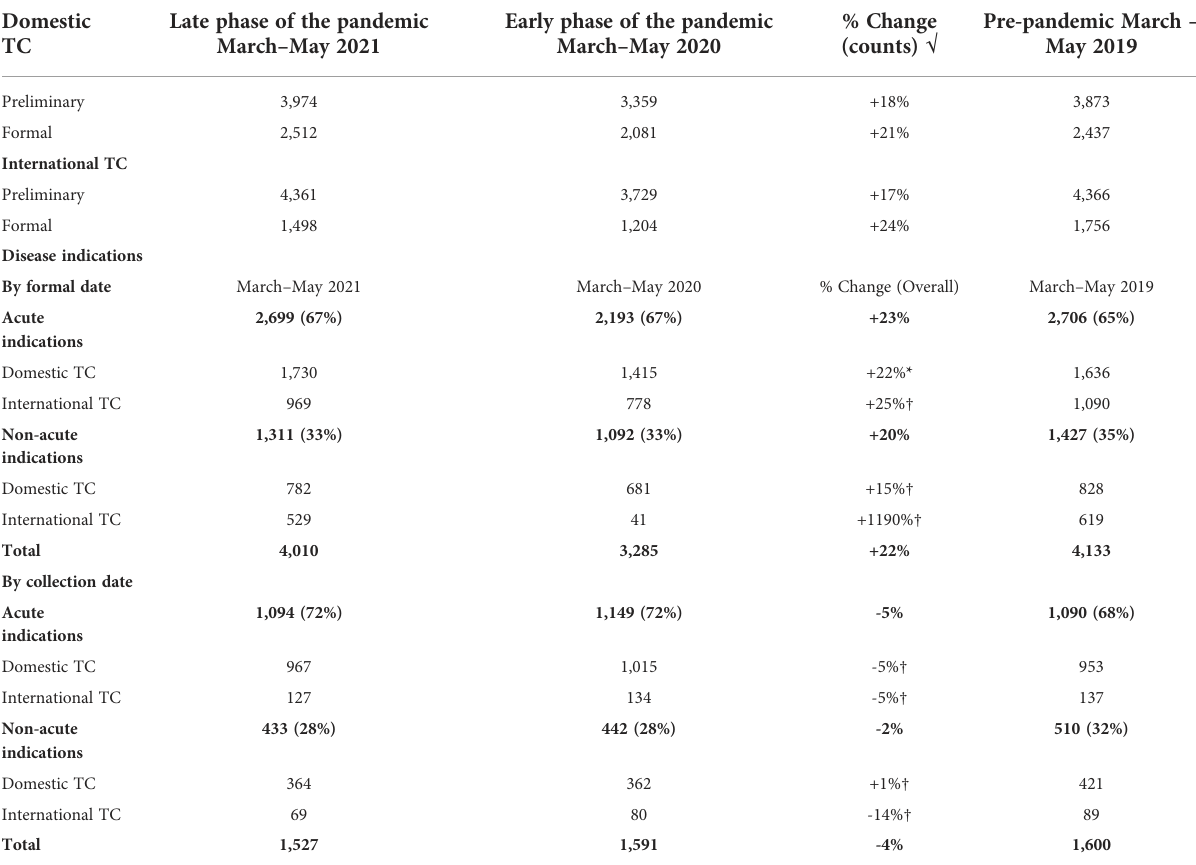
TABLE 1 Donor searches and disease indications for allogeneic hematopoietic stem cell